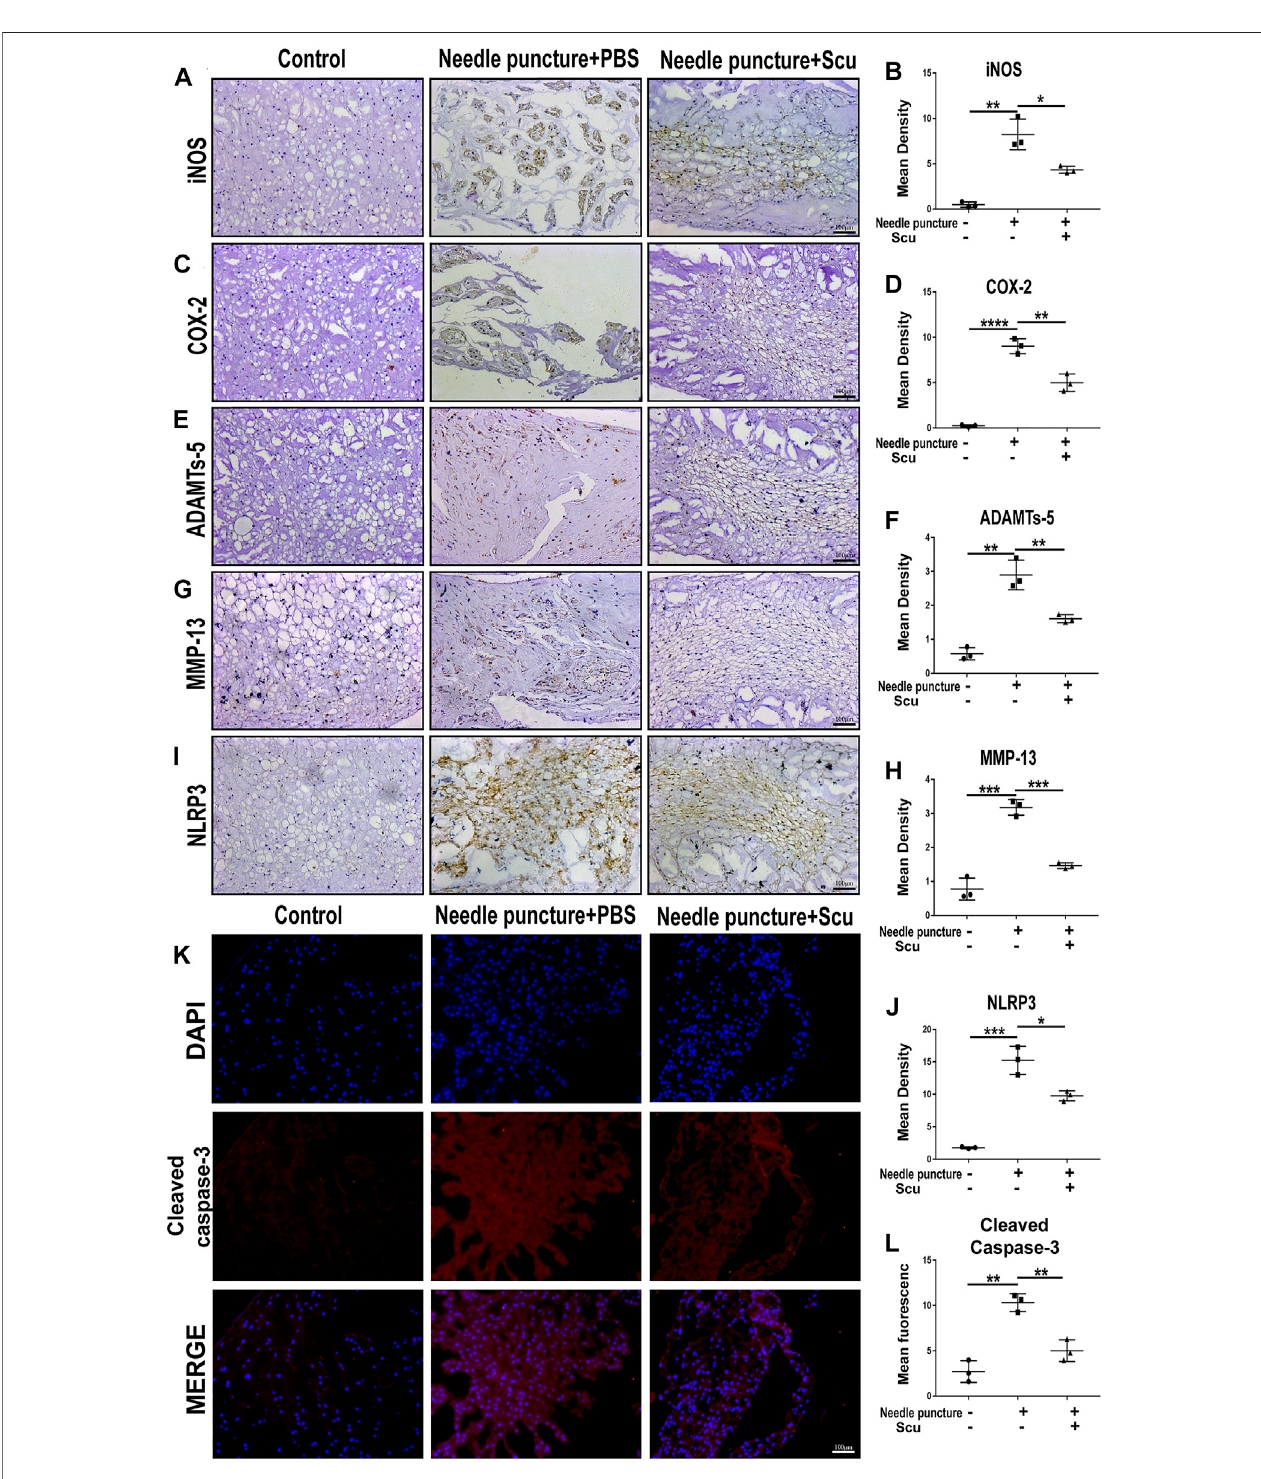
FIGURE6| ScutellarinalleviatesthedegenerationofIVDinaratIVDDmodel. (A – J) TheexpressionlevelsofiNOS,COX-2,ADAMTS-5,MMP-13,andNLRP3inIVD tissues from the con group ( n = 5), needle puncture + PBS injection group ( n = 5) and needle puncture + scutellarin injection group ( n = 5) were detected by immunohistochemistry (scale bar: 100 μ m). (K,L) The expression levels of cleaved caspase-3 in IVD tissues from each indicated group were assayed by immuno fl uorescence staining (scale bar: 100 μ m). Each experiment was performed three times independently. (* p < 0.05, ** p < 0.01, *** p < 0.001).